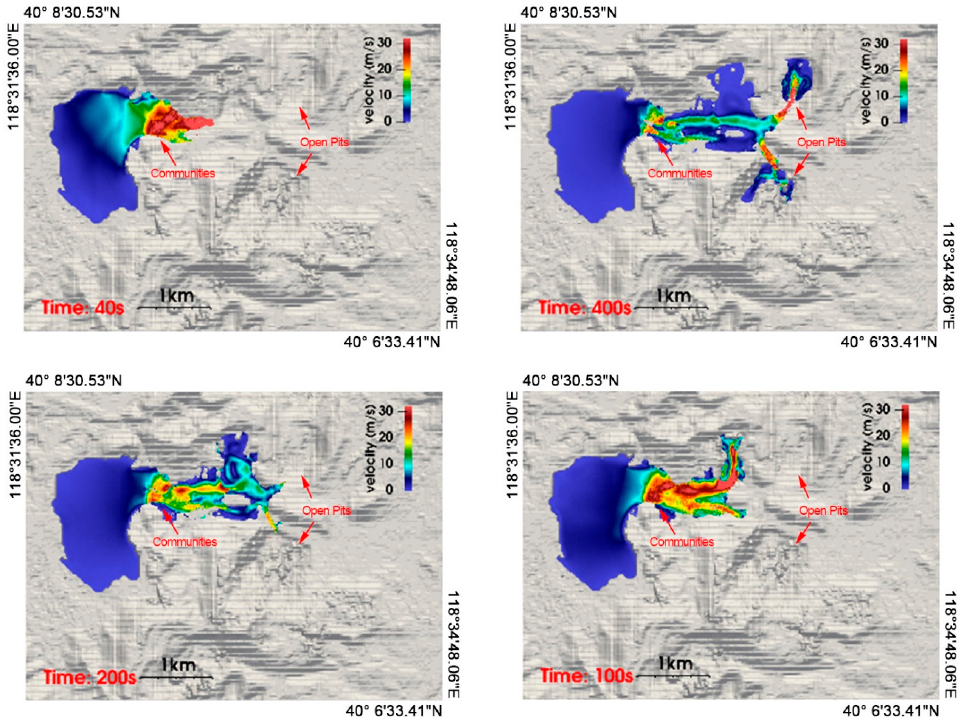
Figure 11. Numerical results of the ‘overhead tailings pond’ dam failure routing.